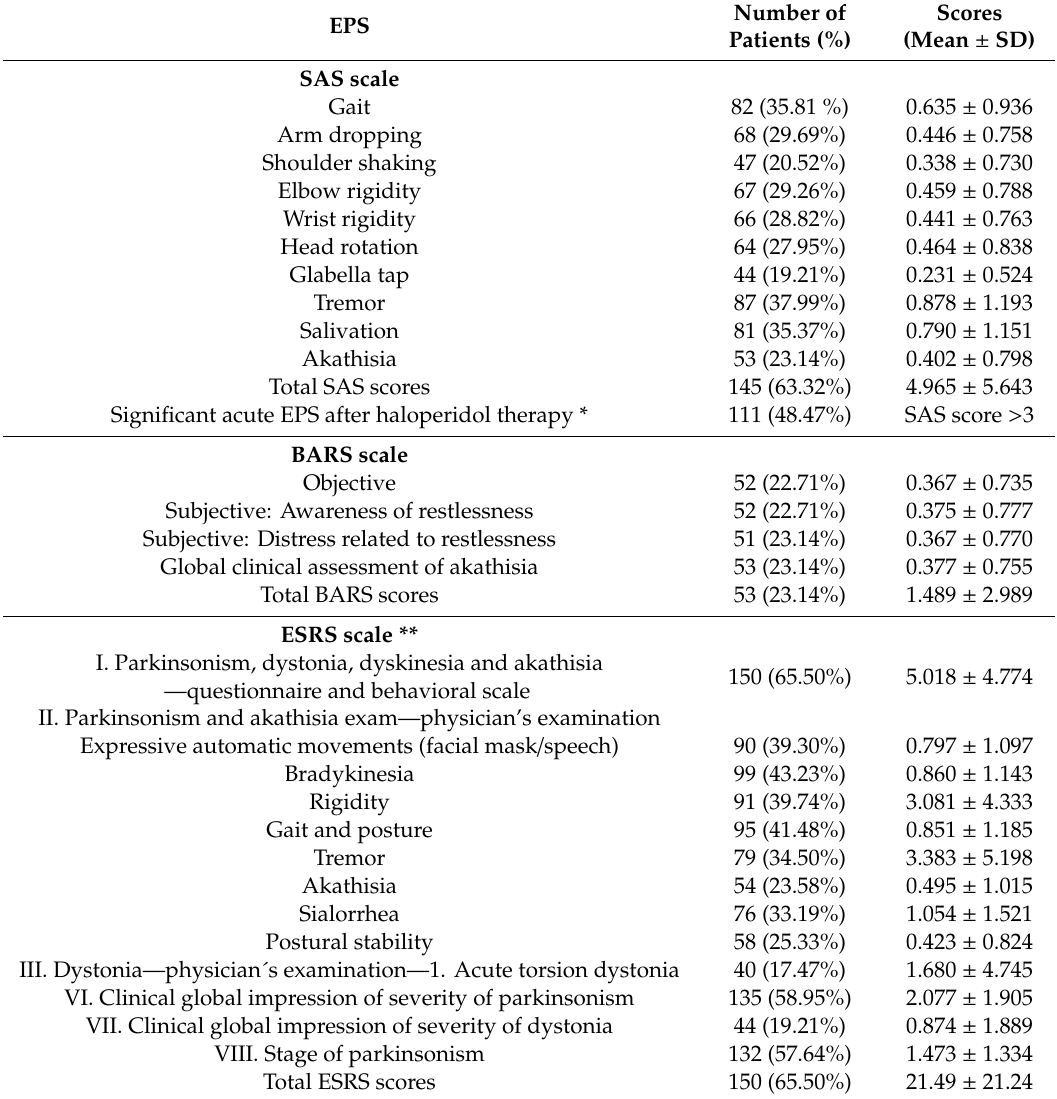
Table 2. Number and percentage (%) of schizophrenia patients with particular acute extrapyramidal side e ff ects (EPS) and its severity (scores), as assessed with the Simpson–Angus Rating Scale for Extrapyramidal Side E ff ects (SAS), the Barnes Akathisia Rating Scale (BARS) and the Extrapyramidal Symptom Rating Scale (ESRS) scales following haloperidol